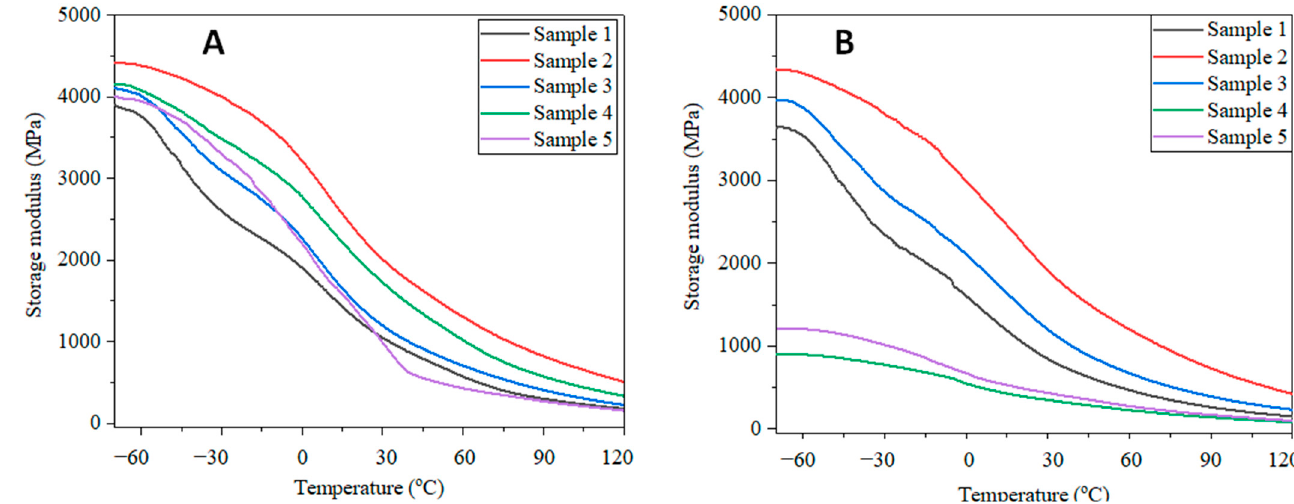
Figure 6. Storage modulus results of the untreated ( A ) and EB compatibilized ( B ) PP/GTR/WF composites.